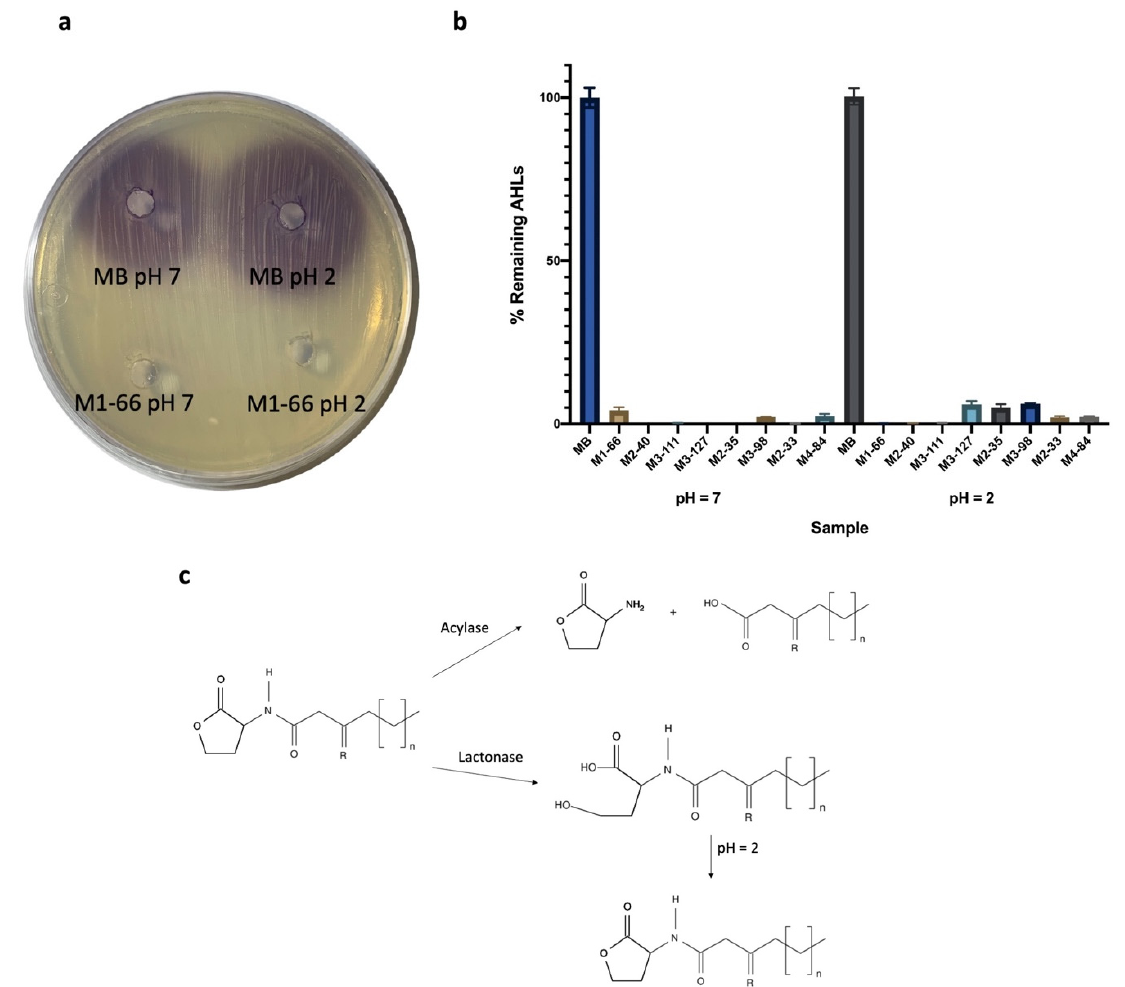
Figure 1. Detection of the remaining C10-HSL after incubation with the AHL-degrading strains at pH 7 and pH 2. ( a ) Diffusion agar-plate assay to detect C10-HSL using the biosensor strain C. violaceum VIR07. ( b ) HPLC-MS measurements of C10-HSL. Values are referred to as % remaining AHLs. Cell-free MB medium was used as negative control. Initial AHL concentration was 10 µM. This assay was repeated three times. Error bars show standard deviations. ( c ) Schematic description of the QQ reactions that may occur.